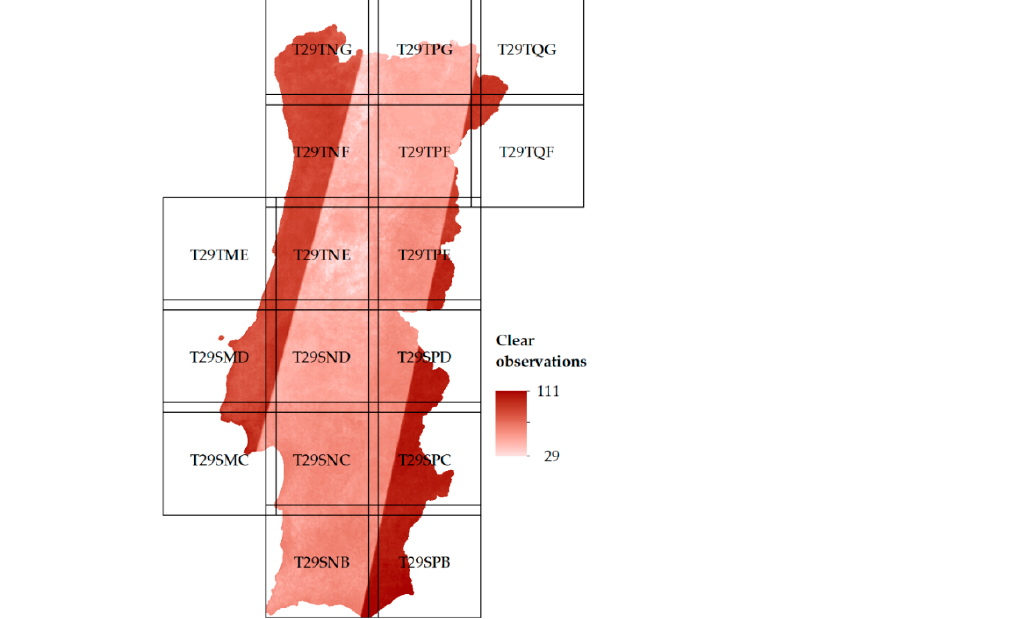
background represents the number of clear observations in the time series used, which ranges from 29 (light red) to 111 observations (dark red).